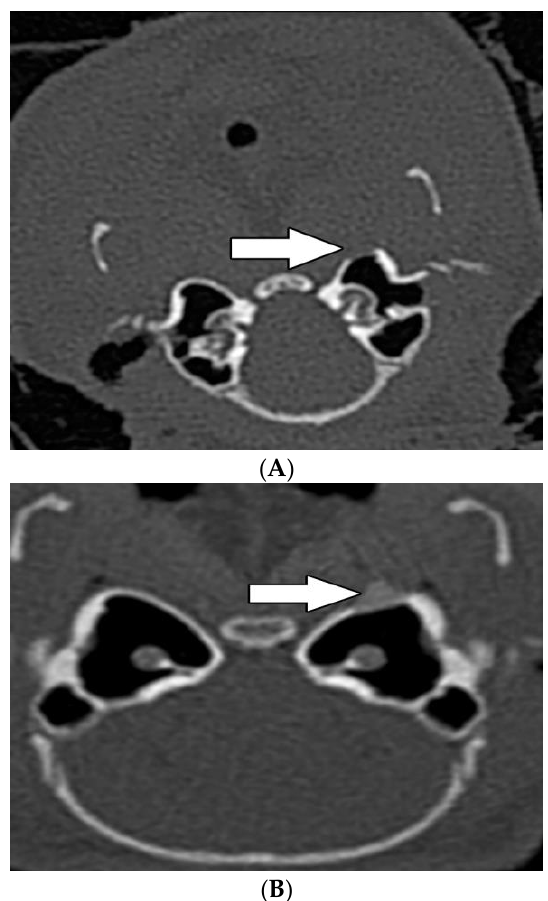
Figure 6. Radiological examination by HRCT at the level of the tympanic bulla, 60 days after implantation of MSCs in group A ( A ) and group B ( B ). White arrows show the place of the implanted biomaterial into the bone